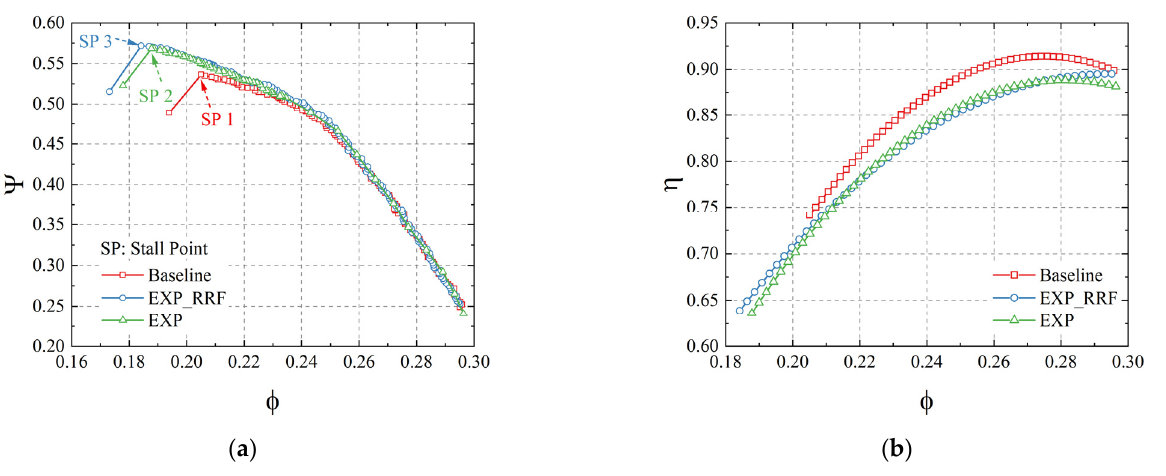
Figure 13. The results of the oscillator–compressor experiments: ( a ) pressure rise characteristics; and ( b ) efficiency characteristics.